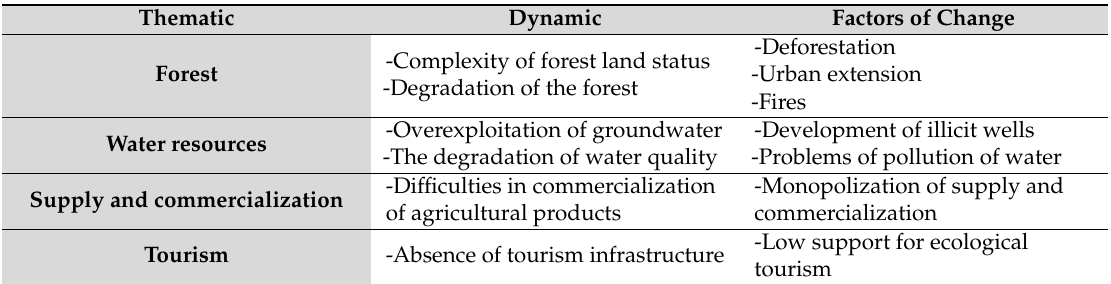
Table 3. Overview of the main dynamics explored during the game.